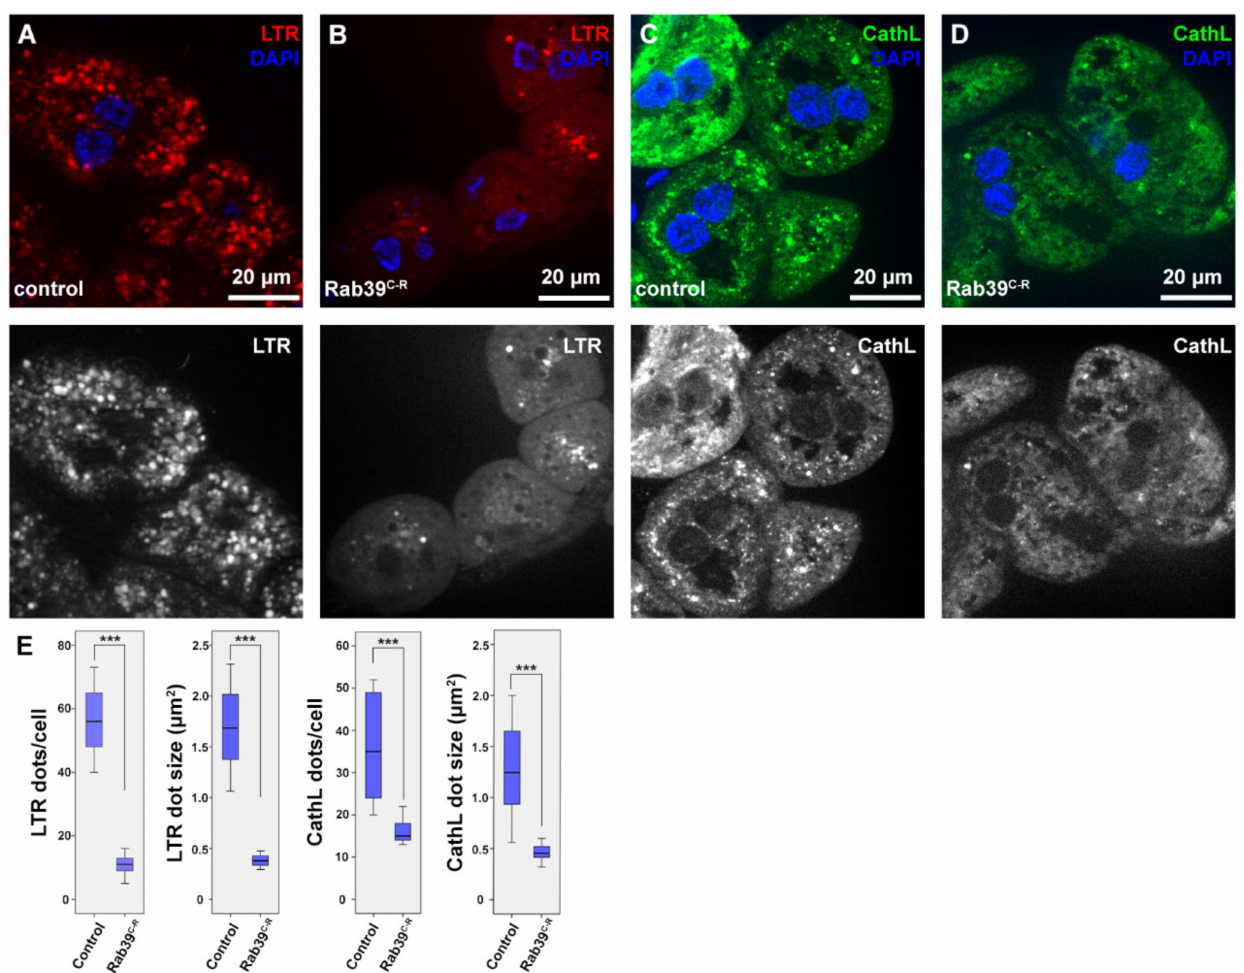
Figure 1. Endolysosomal distribution is altered in Rab39 C-R garland nephrocytes of L3 stage wandering larvae. ( A , B ) Acidic organelles were marked using LTR to depict endolysosomes in control ( A ) and Rab39 C-R ( B ) nephrocytes. Rab39 mutant nephrocytes contain significantly fewer and smaller LTR-positive vesicles. Please note that the smaller nuclei in B, when compared to A are only the result of natural deviation in nucleus size. ( C , D ) CathL was immunostained to show Golgi-derived vesicles, acidic and even non-acidic lysosomes in control ( C ) and Rab39 mutant ( D ) nephrocytes. CathL puncta were fewer and smaller in Rab39 mutant nephrocytes. ( A – D ) Respective red ( A , B ) and green ( C – D ) channels are shown in grayscale. ( E ) Quantifications of the LTR and CathL experiments, n = 10 cells. None of the samples showed Gaussian distribution. Medians are shown as horizontal black lines within the boxes. Bars show the upper and lower quartiles, and the whiskers plot the smallest and largest observations. *** p < 0.001. Heterozygous Rab39 C-R animals in A,C,E were used as